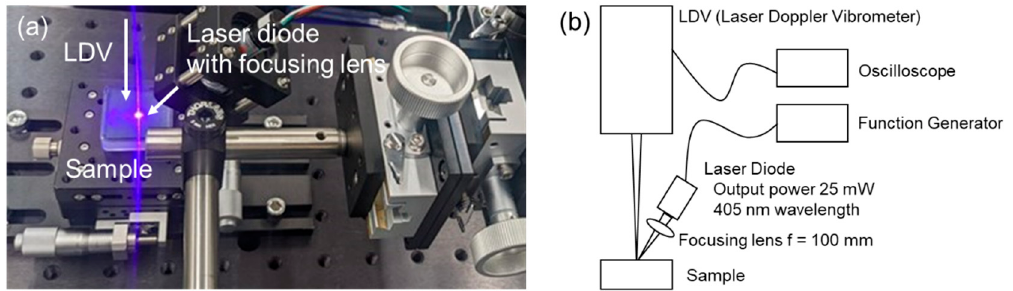
Figure 3. Experimental setup of L-RFA using sweep pulse excitation scheme: ( a ) actual irradiation setup and ( b ) configuration diagram.